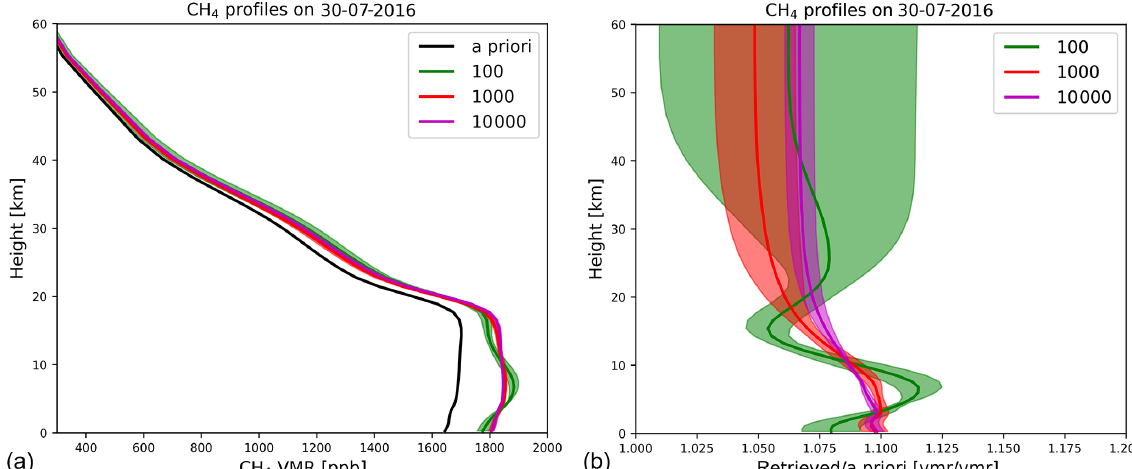
Figure 3. The SFIT4NIR a priori and the retrieved CH 4 vertical profiles (a) , together with the ratios of the retrieved profiles to the a priori profile (b) , with different regularization strength α values.